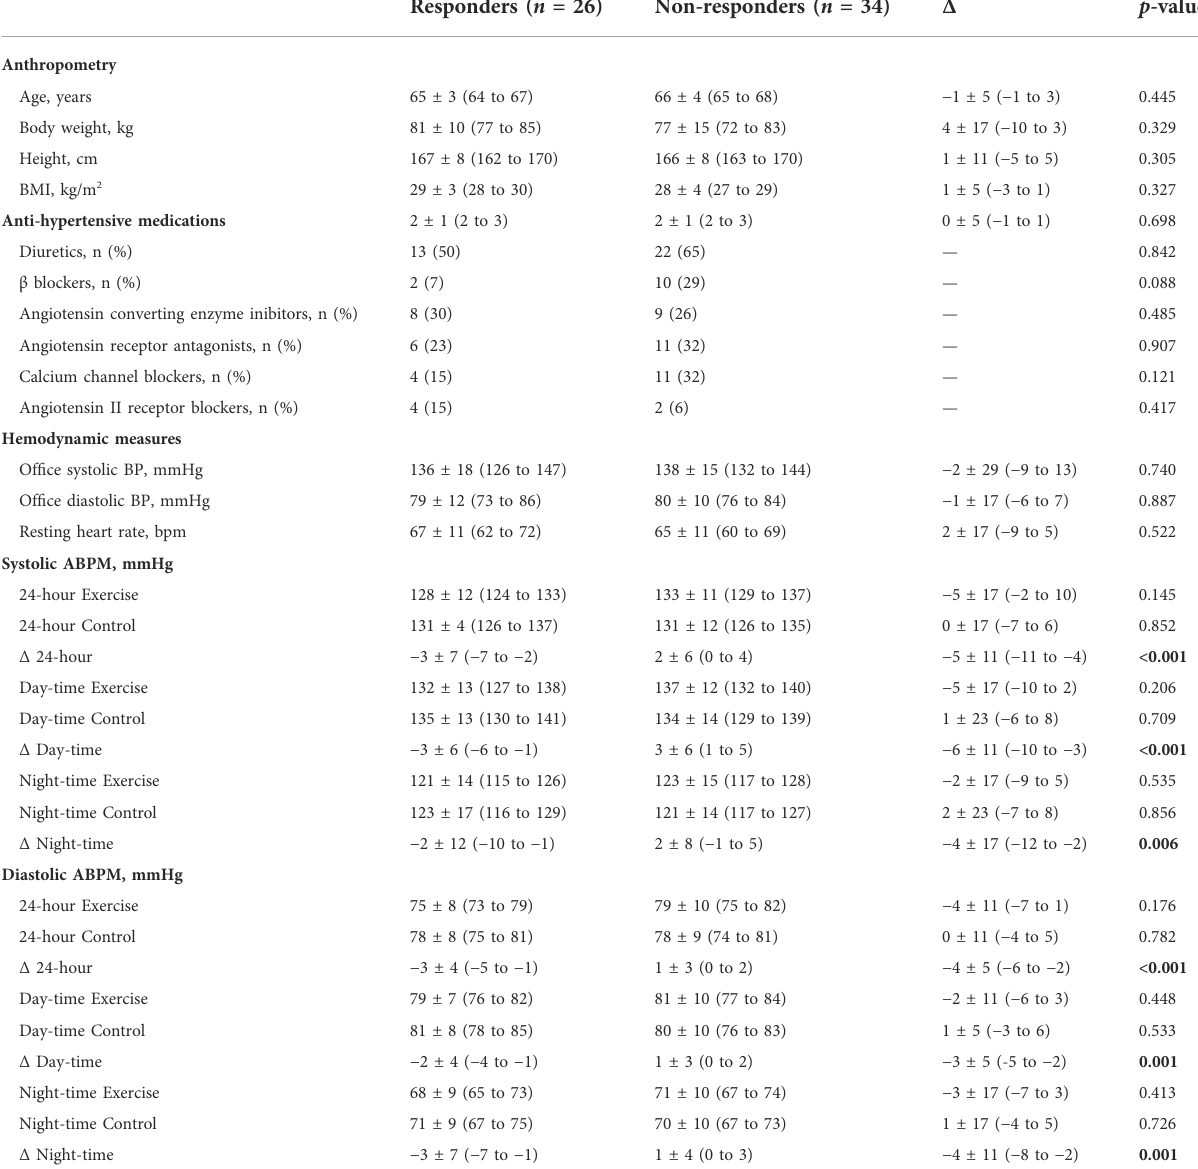
TABLE 2 Differences in characteristics between responders ( > 2 mmHg for diastolic BP) and non-responders who did not present this